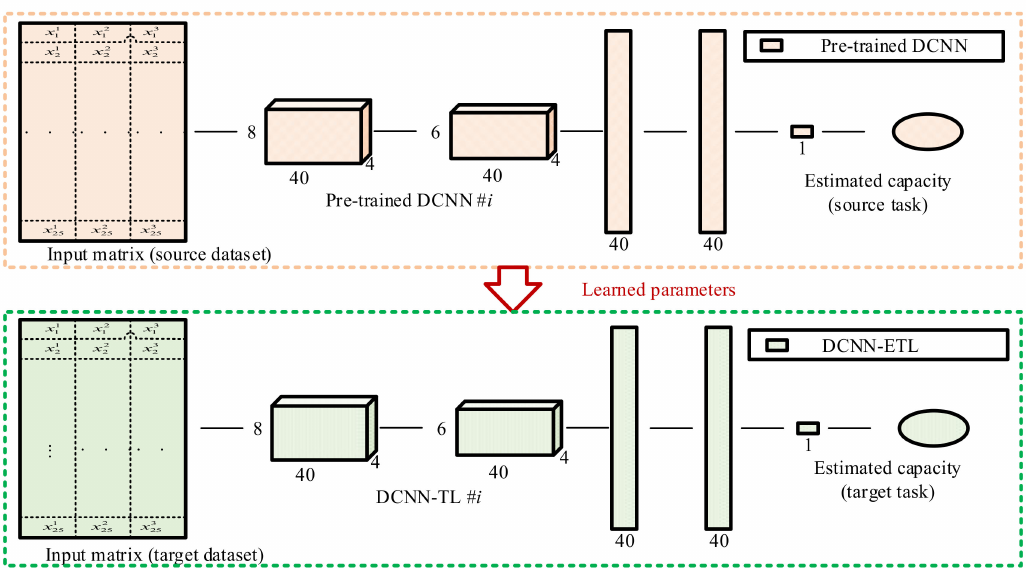
Figure 4. The overall framework of the DCNN-ETL prediction